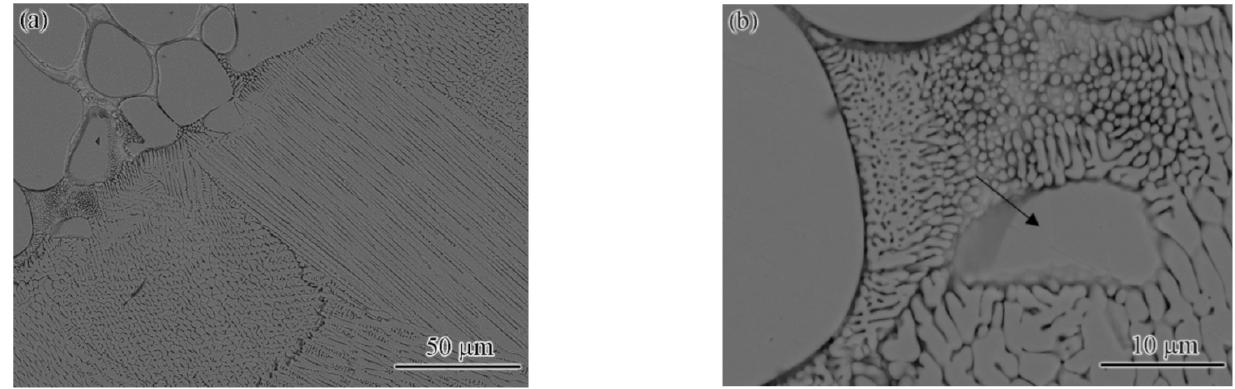
Figure 7. The SEM (backscattered electron) images of exact morphologies of the fusion line: ( a ) low magnification and ( b ) high